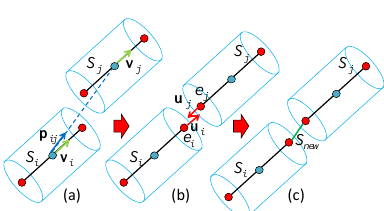
Fig.7 An axis segment of pipe